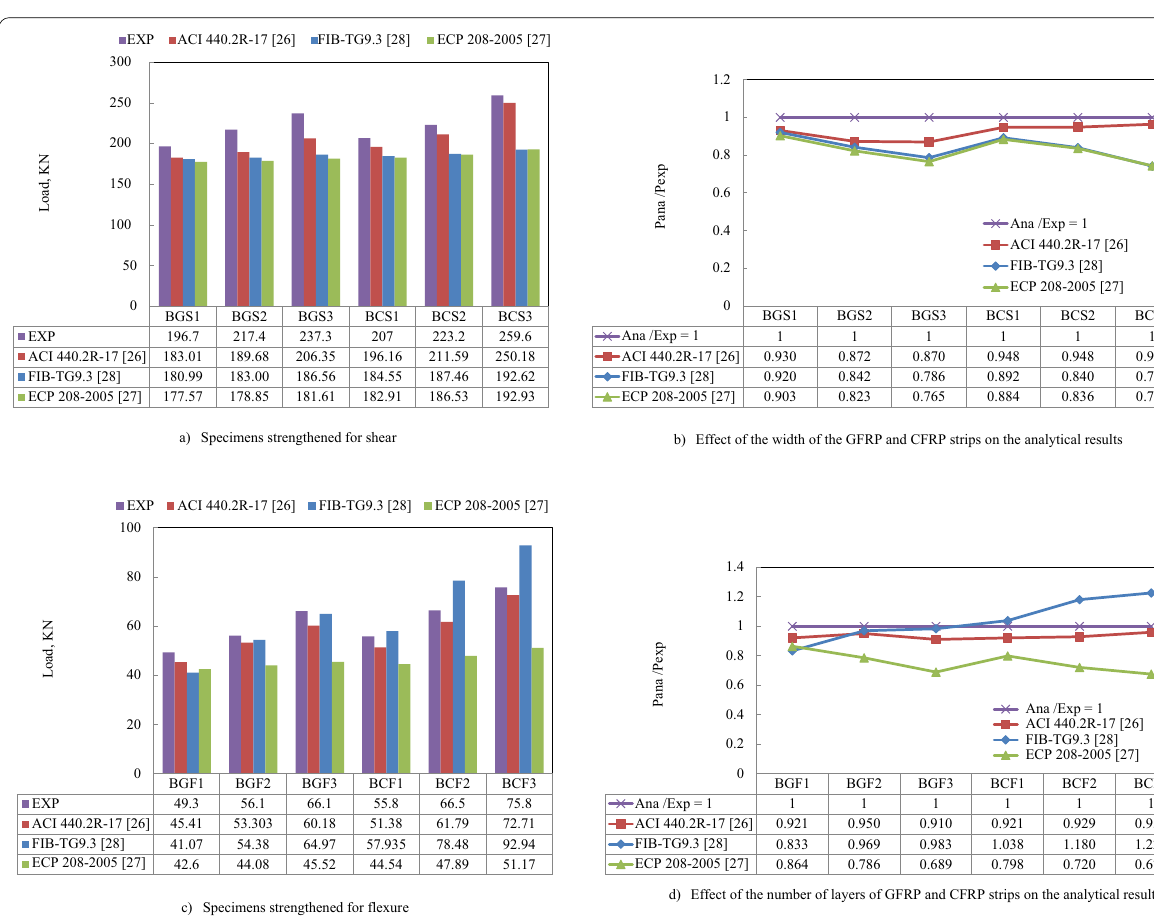
Fig. 14 Comparison between experimental results and those predicted by design guidelines